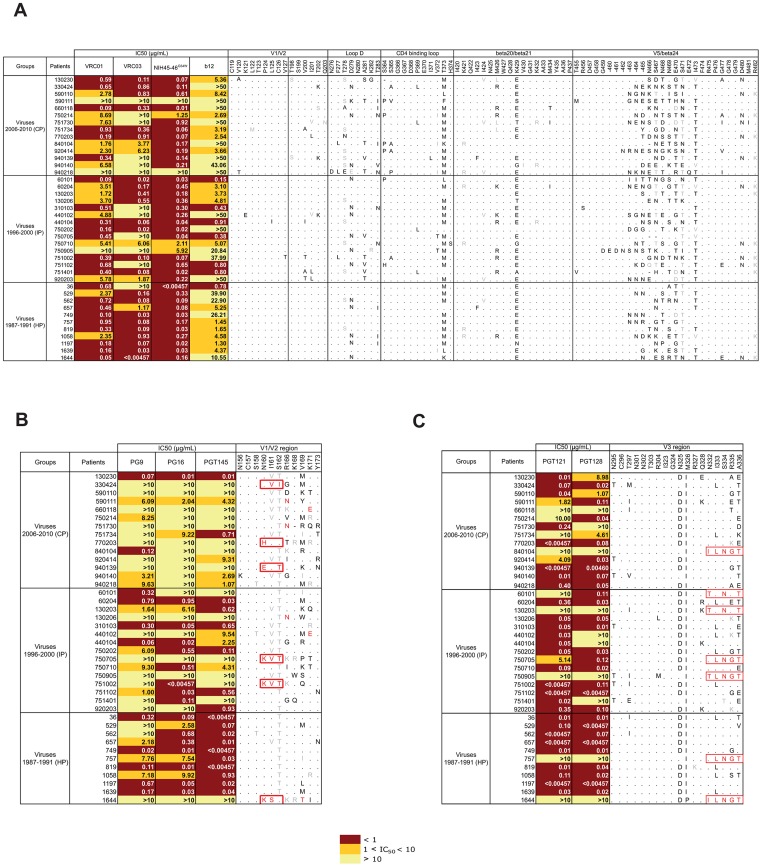
Relationship between resistance to HuMoNAbs and changes in envelope targeted residues.The 40 env sequences of viruses from historical (HP), intermediate (IP) and contemporary patients (CP) were aligned with the HXB2 reference sequence. Key residues targeted by b12, VRC01, VRC03 and/or NIH45-46 [A], PGT9, PG16 and/or PGT145 [B], and PGT121 and/or PGT128 [C] are presented. Identical residues are represented by dots. Conserved and non-conserved residues are in grey and black, respectively. Substitutions previously shown to confer neutralization resistance are in red. The neutralization sensitivity (IC50) of each HIV-1 variant is indicated for each HuMoNab. IC50 values are color coded with increasing darker colors used to indicate increasing neutralization sensitivity.